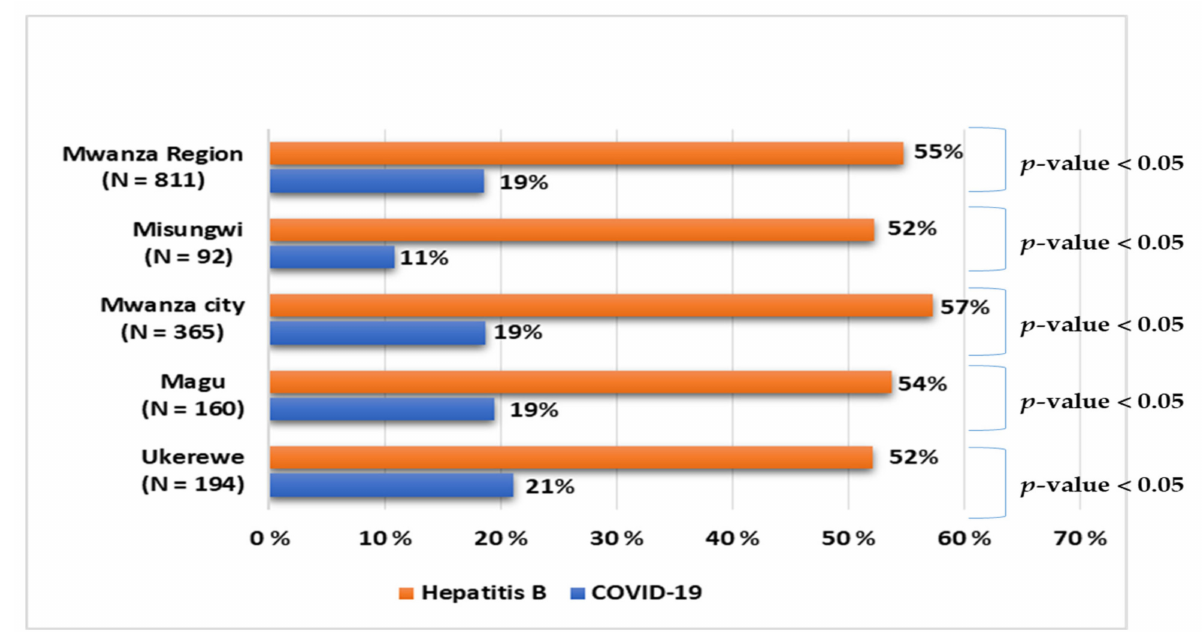
Figure 2. Comparison of Hepatitis B and COVID-19 vaccine status among health